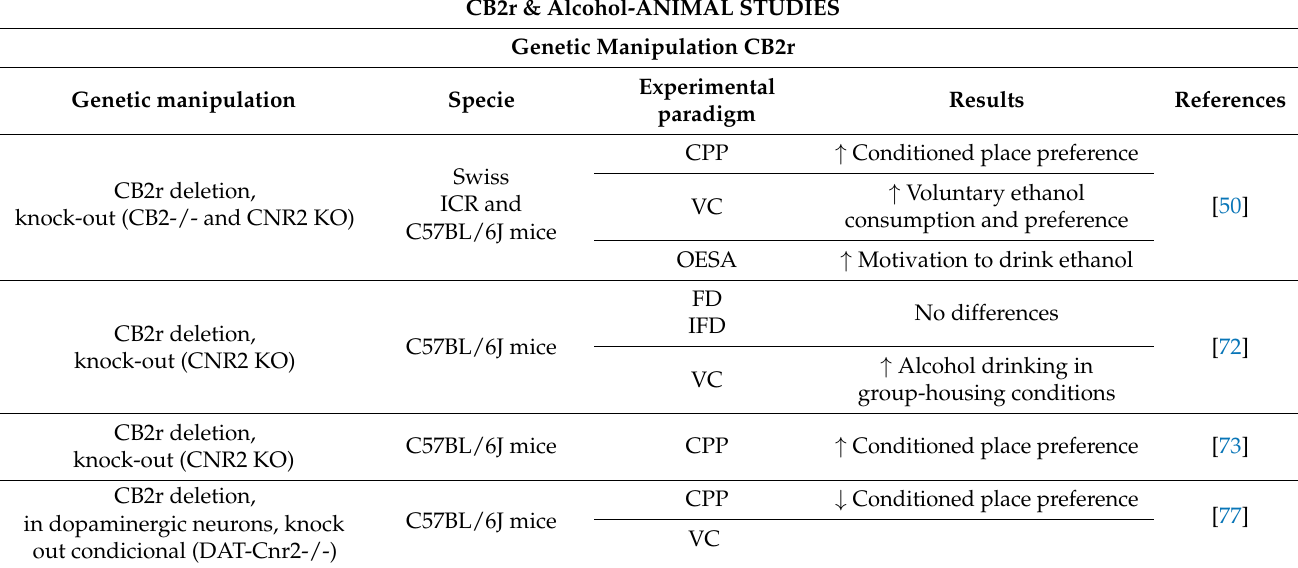
Table 1. Main findings supporting the involvement of CB2r in the regulation of the reinforcing and motivational effects of